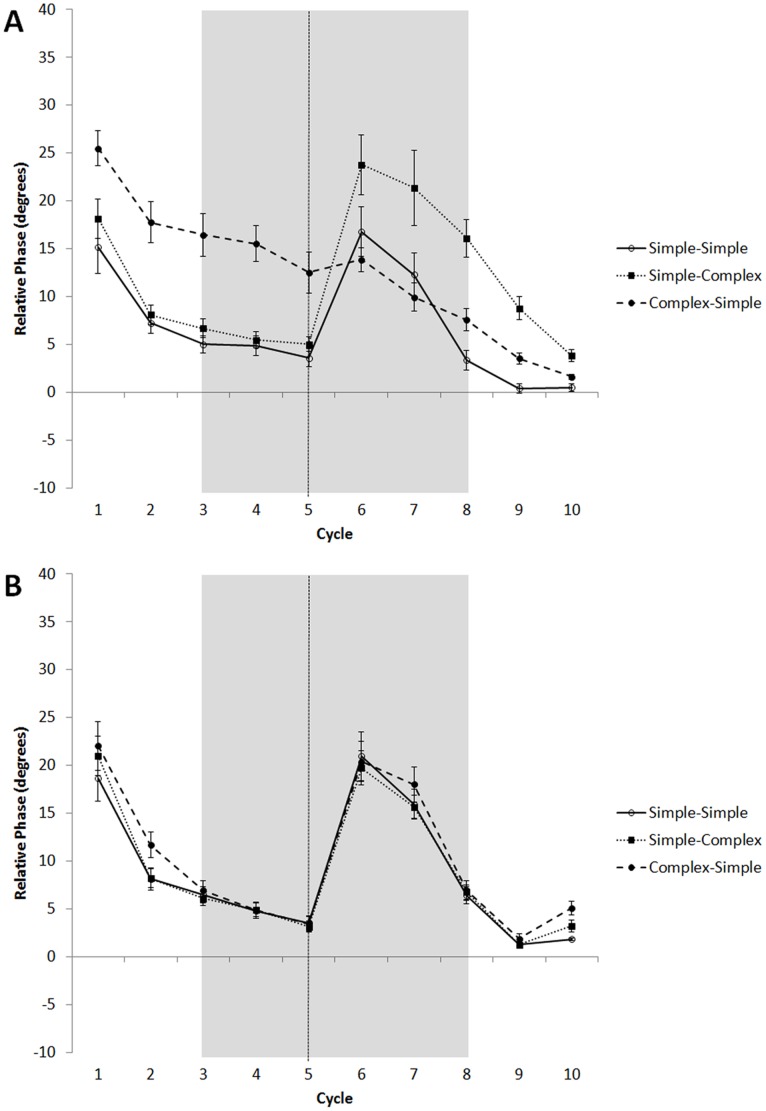
Mean average relative phase over course of trial for filled switch sequences for Americans (A) and Indians (B) in Experiment 1: simple-simple, simple-complex, and complex-simple conditions.Error bars denote between-subject standard error. Some error bars were too small to be visible. Dashed line denotes point of switch. Shaded box denotes window of interest in analyses.